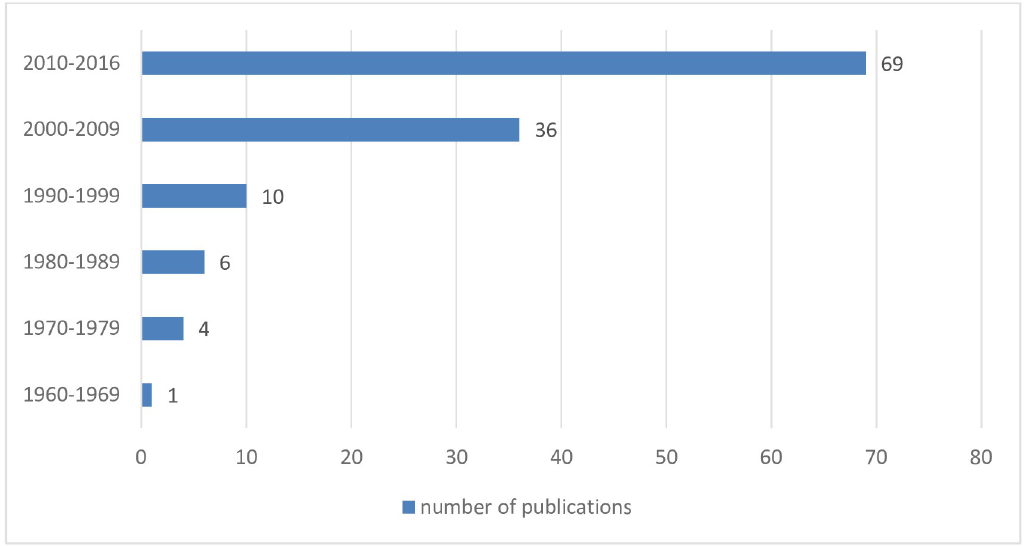
Fig 1. Number of analysed publications on BML which meet the inclusion criteria, time frame from 1960 to 10 April 2016. https://doi.org/10.1371/journal.pone.0175875.g001 PLOS ONE | https://doi.org/10.1371/journal.pone.0175875 April 20,